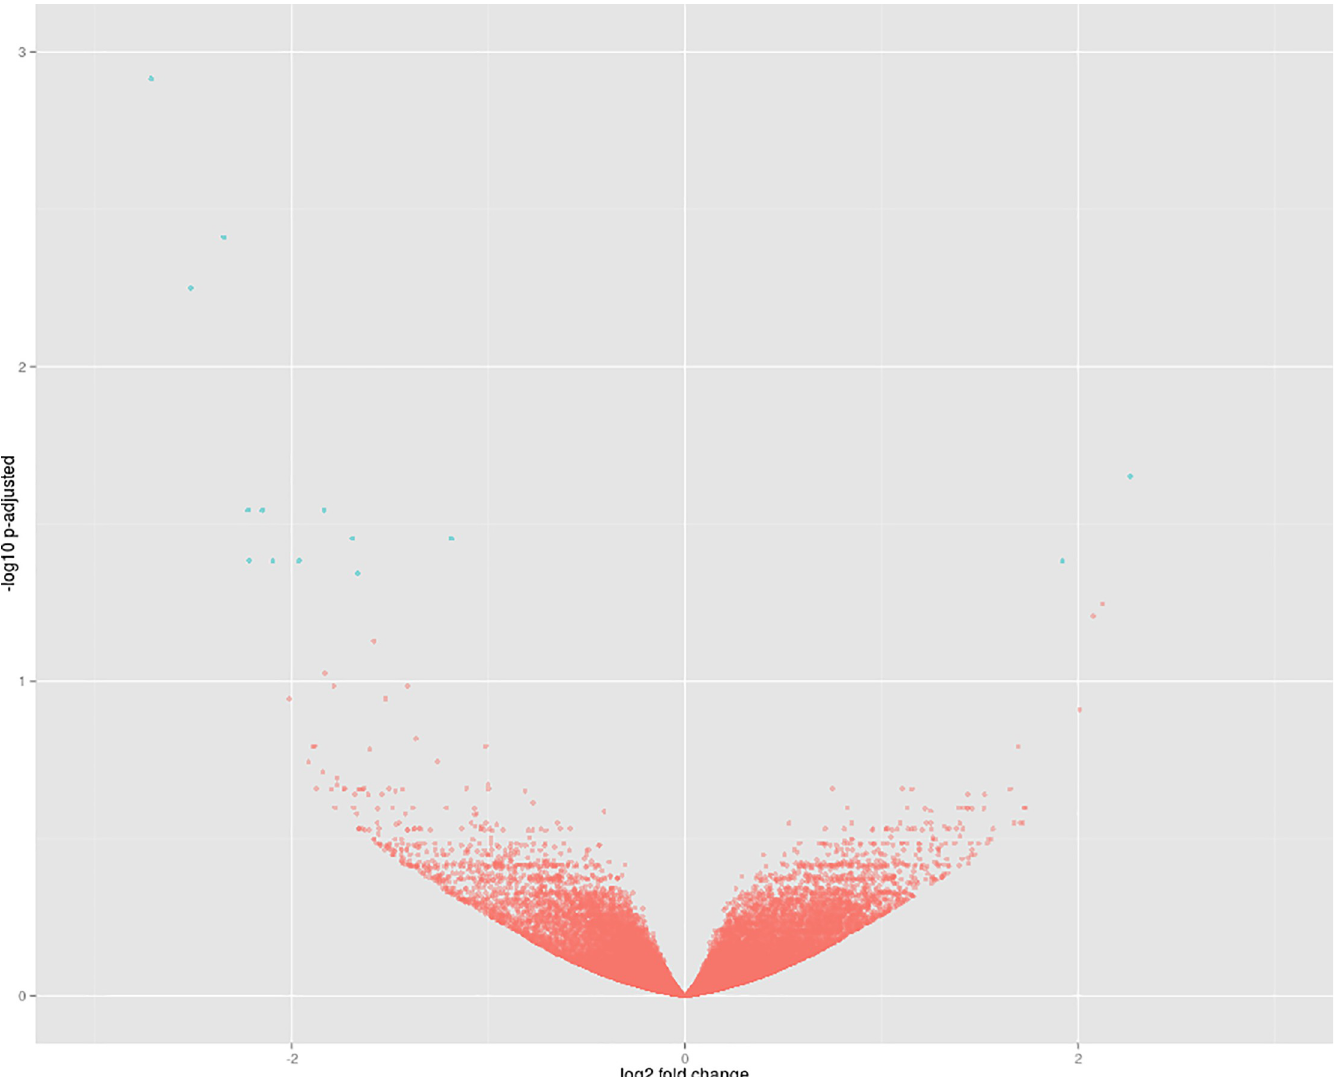
Fig 4. Volcano plot of comparison 4. Dots in blue represent significant differentially expressed genes. The genes of the DOR 364 genotype under restrictive P (Libraries 4–6) are represented to the right of the origin of the coordinate plane, and the genes of the DOR 364 genotype under control P (Libraries 10–12) to the left.